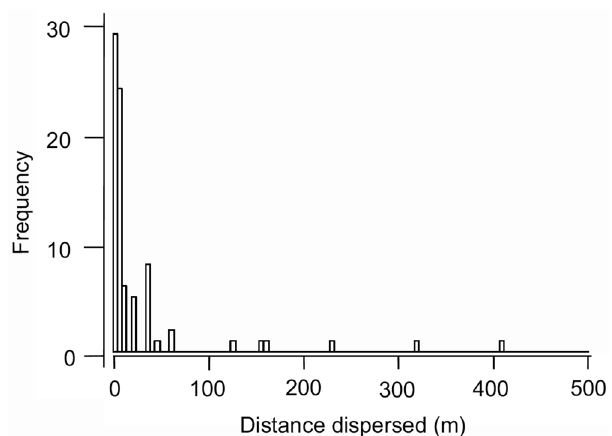
Fig. 6. Shoreline distance dispersed by 104 tagged Symphy- sodon haraldi over a 7-9 day period in Uxi Bay, lago Amanã subsequent to release at their original capture site. Each bar represents a 5 m distance